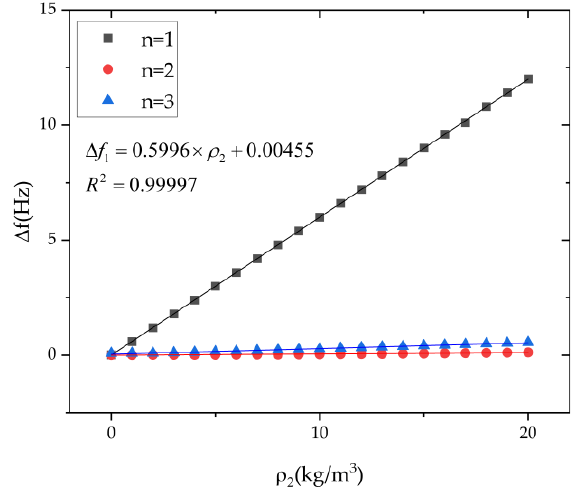
Figure 7. The influence of the second harmonic ρ 2 on the frequency split of n = 1, 2, 3 modes. The variation of the frequency split of the n = 1, 2, 3 modes with varied amount of the third harmonic error is shown in Figure 8. The influence of the third harmonic error on the frequency split of the n = 3 mode is greater than that on the n = 1 and the n = 2 modes. In general, the third harmonic error has little influence on the frequency split of the n = 1, 2, 3 modes. The variation of the frequency split is 2.2 mHz when the coefficient of the third harmonic error increase from 0 kg/m 3 to 20 kg/m